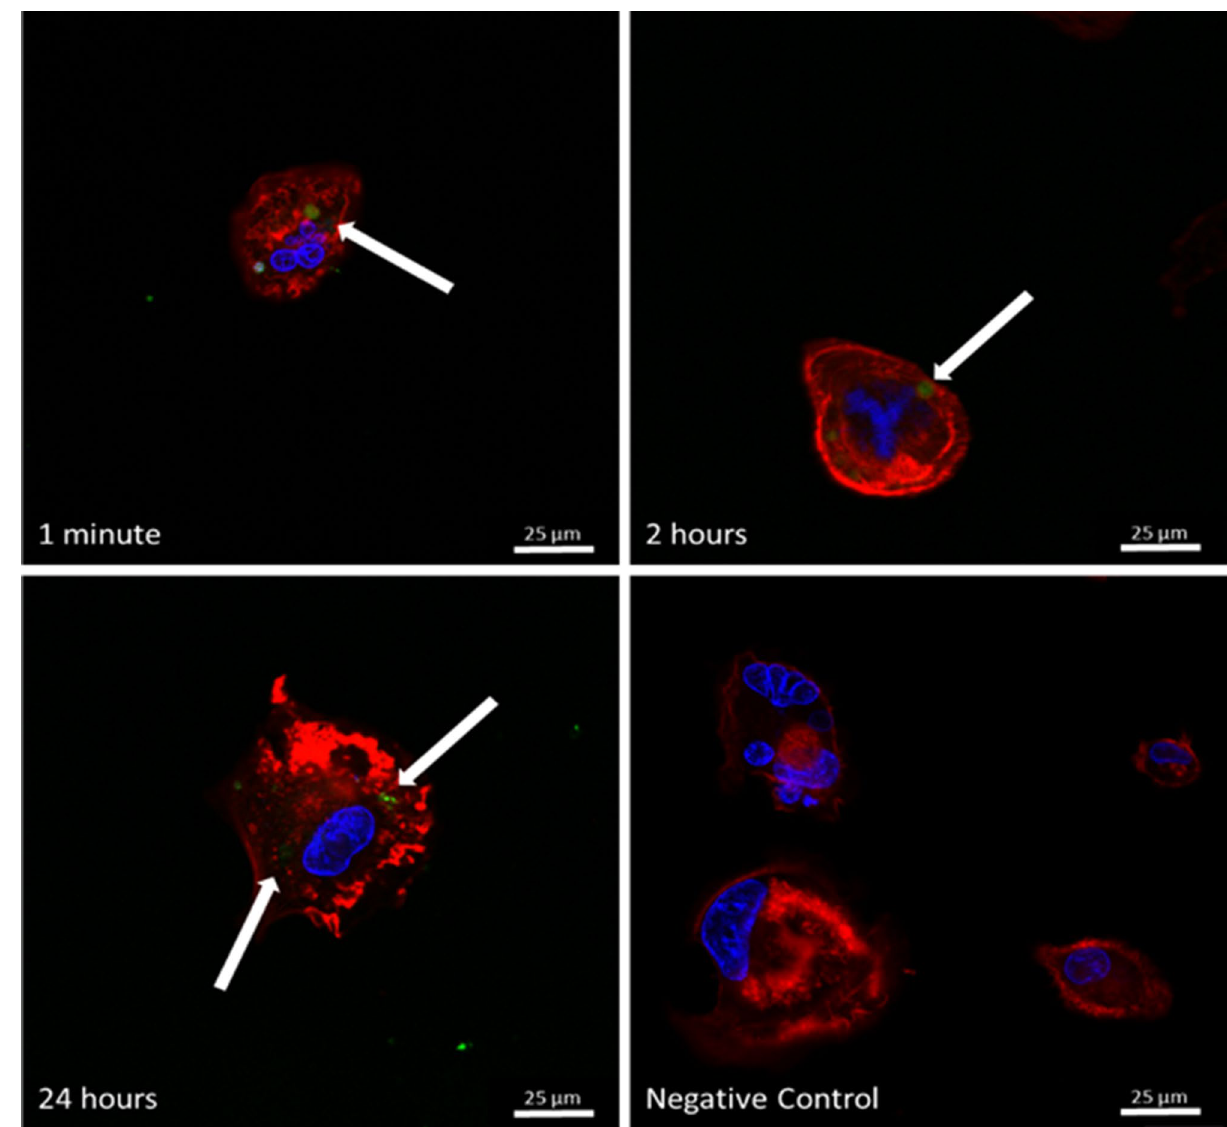
rhodamine phalloidin) and in blue the cell nucleus (stained with DAPI—4 ′ ,6-diamidino-2-phenylindole). The scale bar corresponds to 25 µm. The images were analyzed in confocal microscopy under the Leica TCS SP8- Confocal Microscope at 40 ×